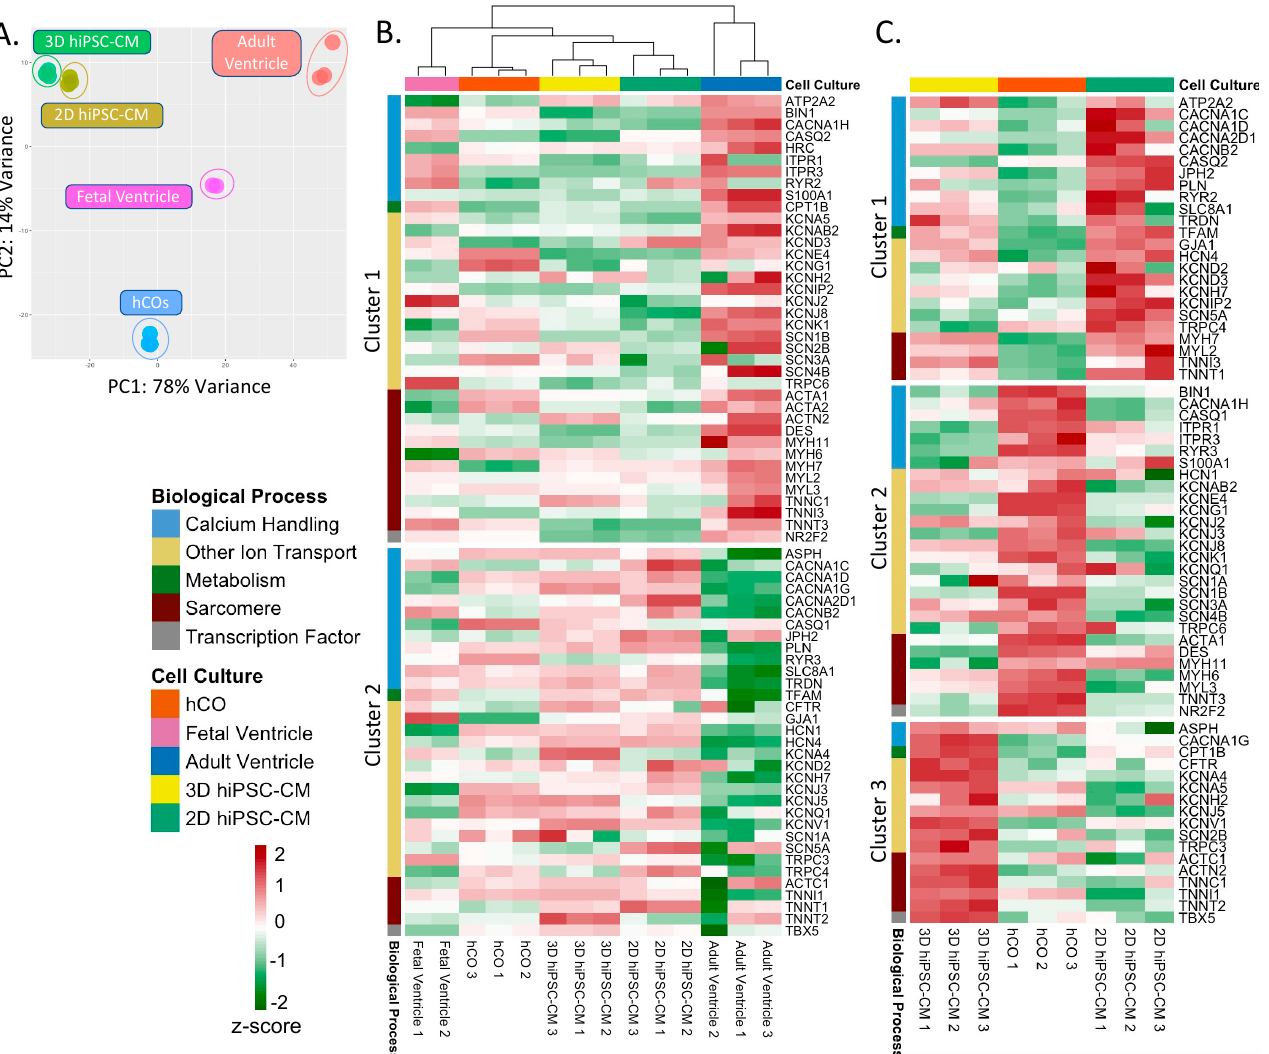
Figure 6. PCA and k-means cluster analysis of a cardiomyocyte specific gene set. ( A ) PCA of cardiomyocyte gene expression in 2D hiPSC-CMs, 3D hiPSC-CMs, hCOs, fetal ventricles and adult ventricles. ( B ) Heatmap of cardiomyocyte gene expression of 2D hiPSC-CMs, 3D hiPSC-CMs, hCOs, fetal ventricles and adult ventricles. Genes were categorized by reported biological processes characteristic of cardiomyocytes. ( C ) Comparison of in vitro hiPSC-CM platforms. Genes were categorized by known cellular functions characteristic of cardiomyocytes.